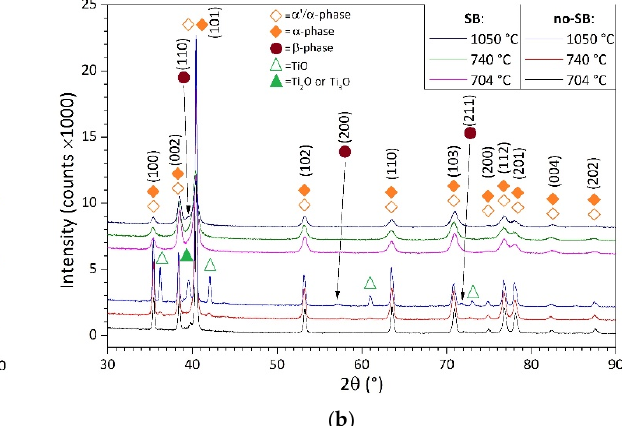
Figure 7. OM micrograph of the cross-section of the 45°-sample ( a ) and 45°-bar ( b ) after heat treat- ment at 1050 °C/60 ′ .